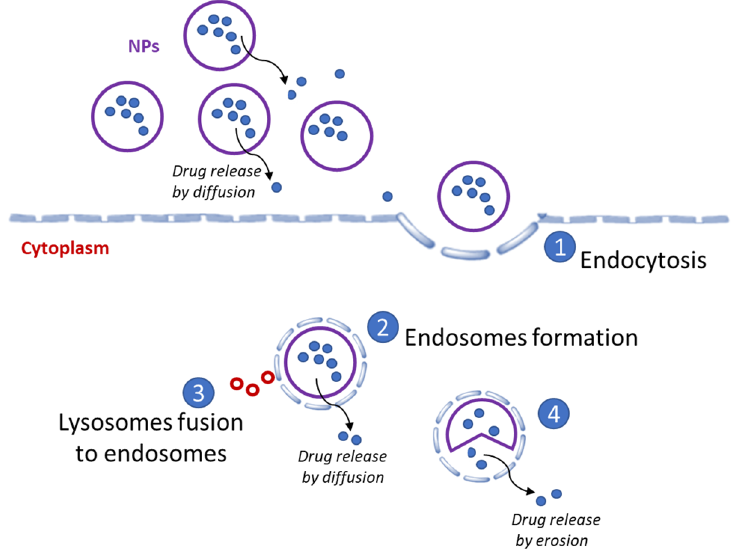
Figure 5. The mechanism of action of polymeric NPs consists of the internalization of the NPs into the cell that is produced through endocytosis, producing changes in the stability and cargo of the NPs. The following step is the cleavage of the NPs by endosome formation and lysosome fusion to release the drug by erosion of the NPs.